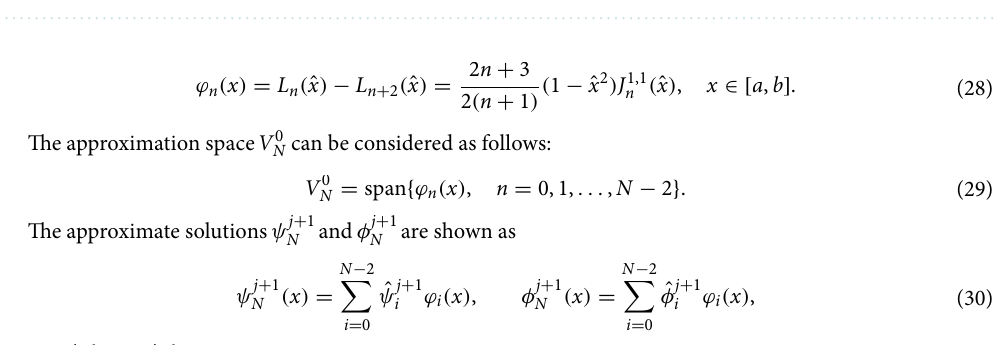
Figure 2. Plots of model (36) for β = 0.99 and α = 1.6